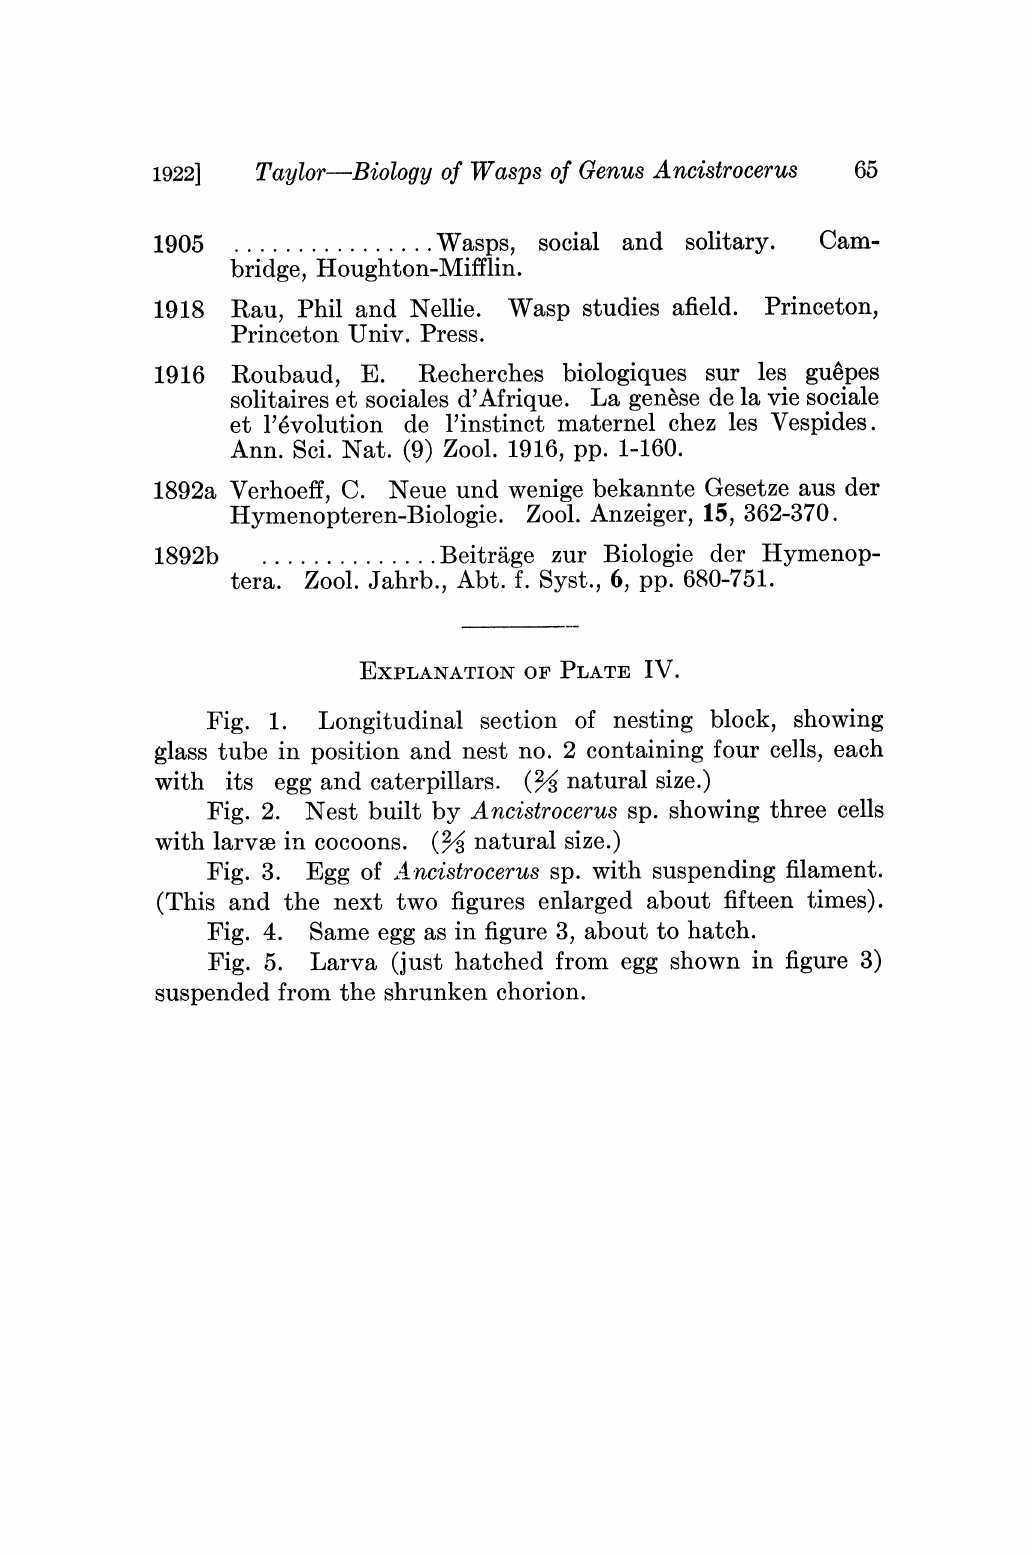
Fig. 1. Longitudinal section of nesting block, showing glass tube in position and nest no. 2 containing four cells, each with its egg and caterpillars. (2/ natural size.) Fig. 2. Nest built by Ancistrocerus sp. showing three cells with larvm in cocoons. ( natural size.) Fig. 3. Egg of Ancistrocerus sp. with suspending filament. (This and the next two figures enlarged about fifteen times). Fig. 4. Same egg as in figure 3, about to hatch. Fig. 5. Larva (just hatched from egg shown in figure 3) suspended from the shrunken